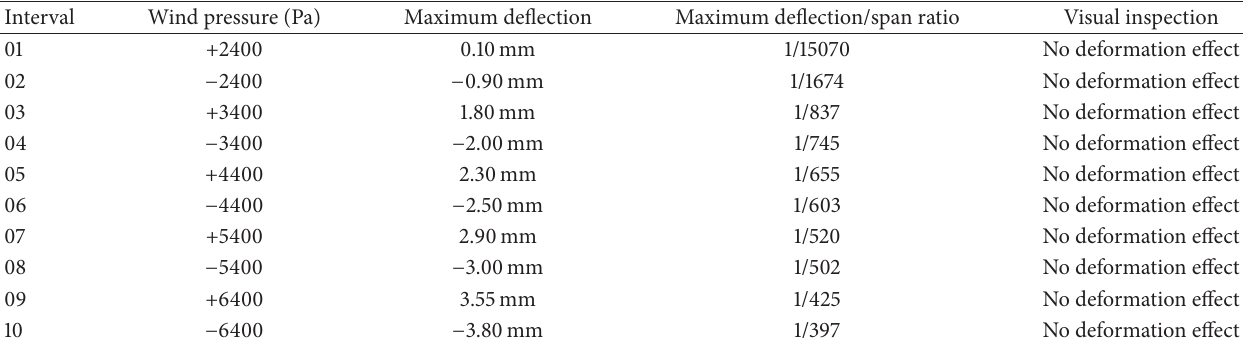
Table 4: Results of wind resistance test.